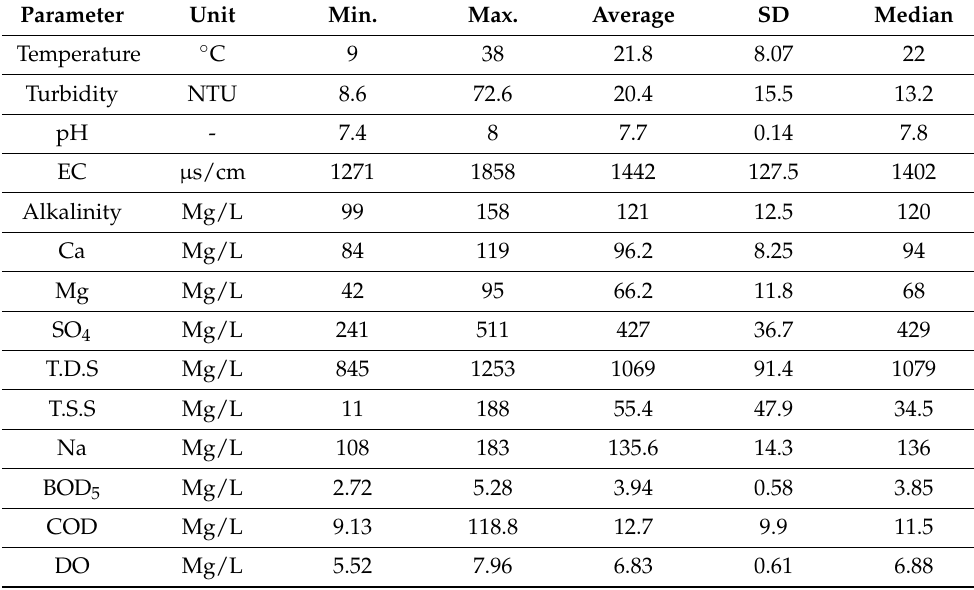
Table 1. The characteristics of the water quality parameters that were measured.